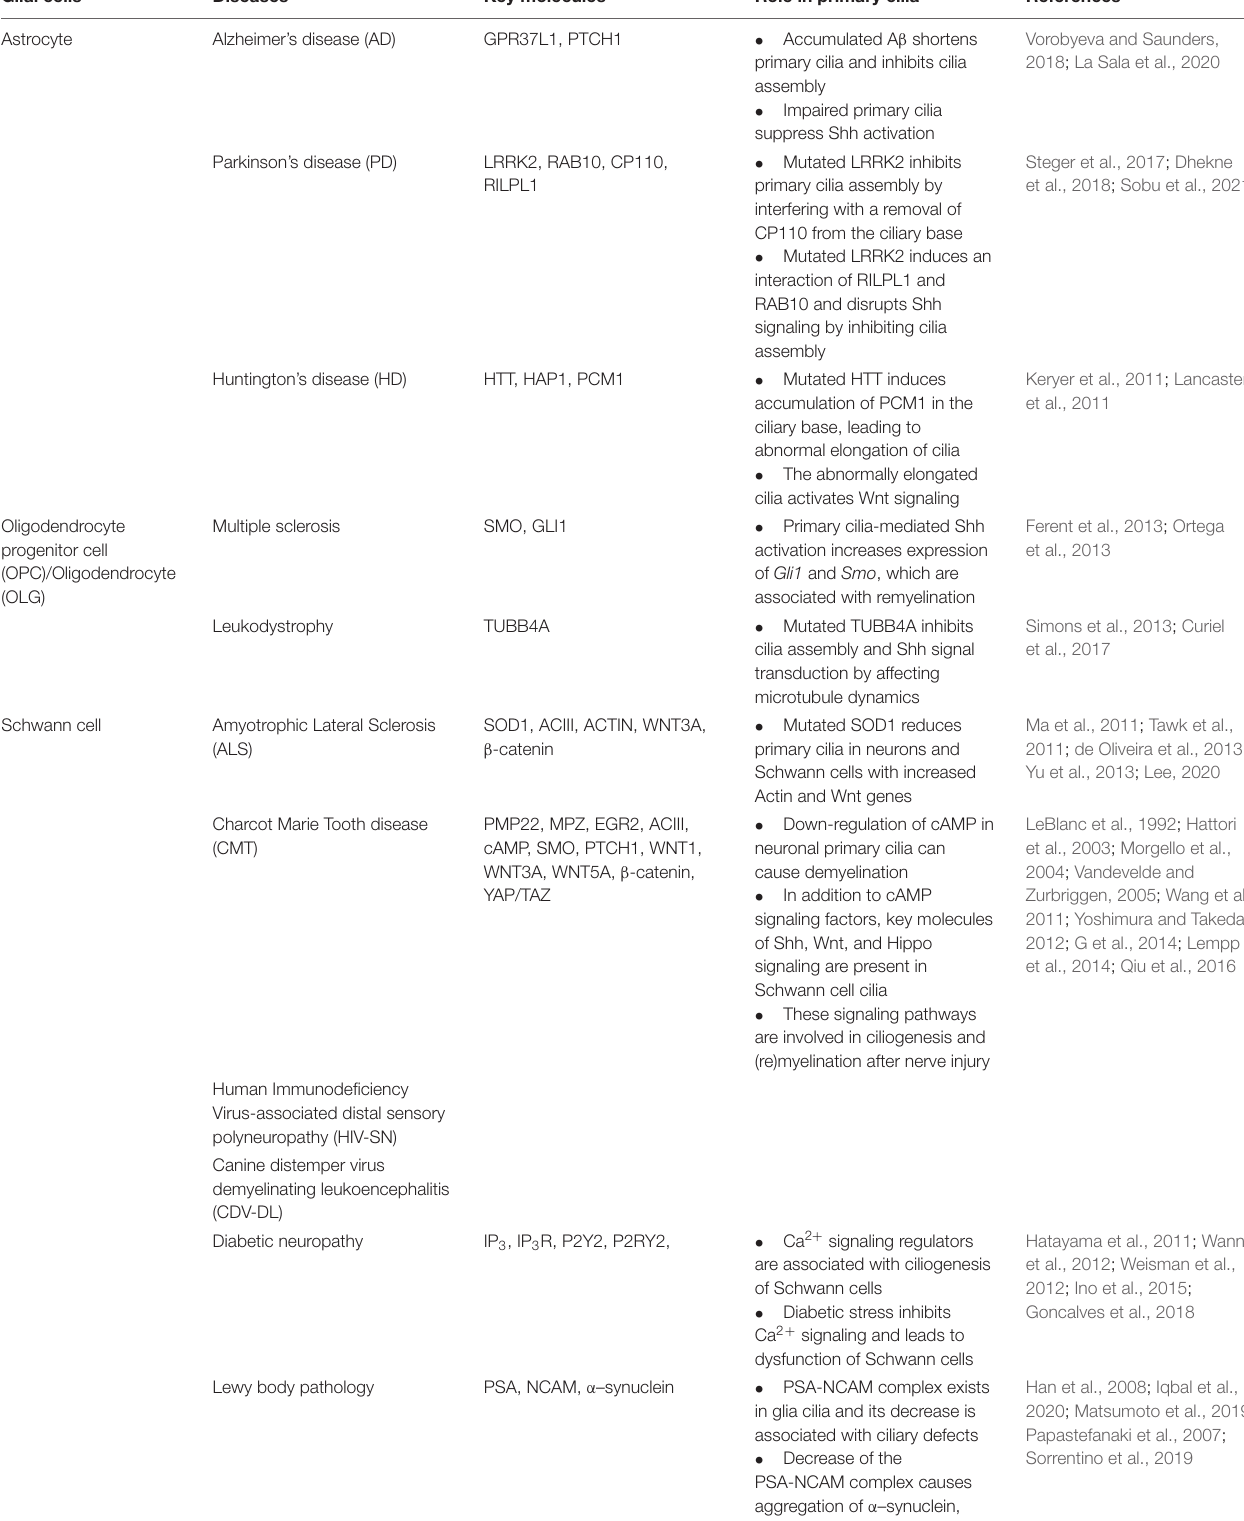
TABLE 1 | Role of glial primary cilia in the pathogenesis of neurodegenerative